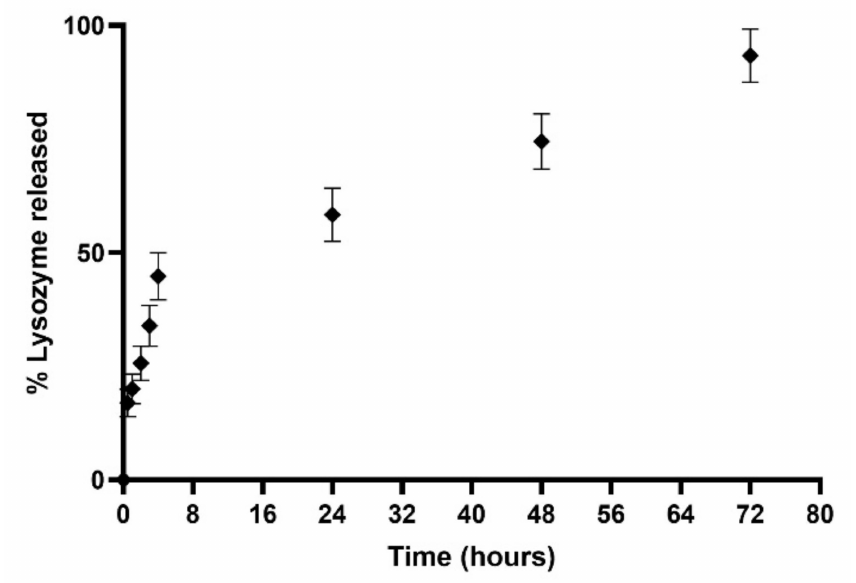
Figure 10. Cumulative (%) release study profile of device 4-produced L-LPs 0.5 mgmL − 1 conducted in PBS (pH 7.4) at 37 ◦ C. Results represent mean ± SD, n = 3 independent